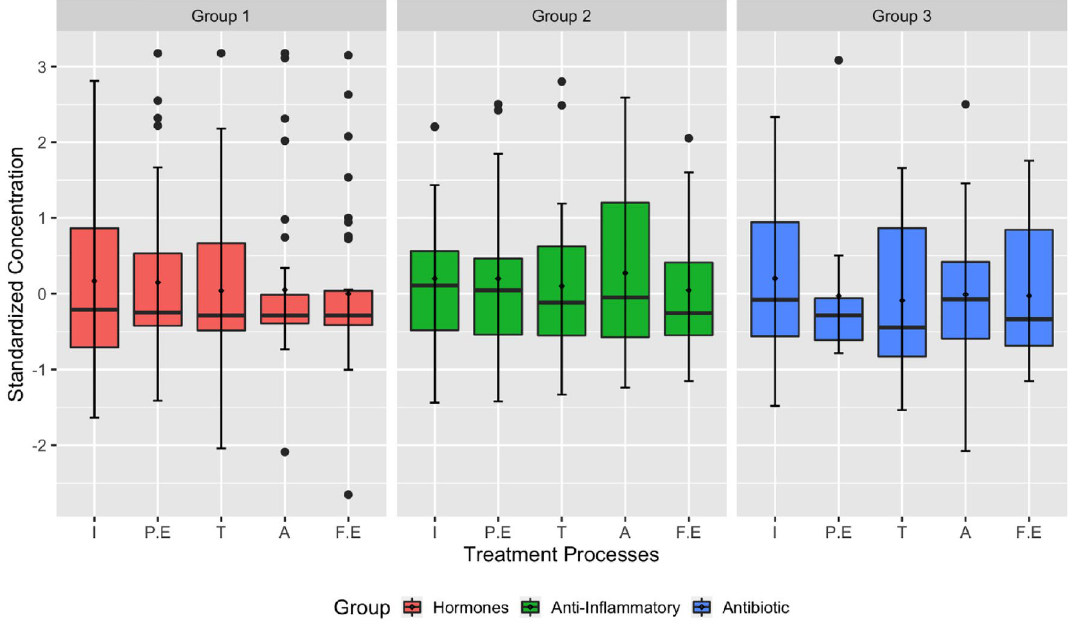
Fig. 2 The boxplots of the removal of compounds for groups across treatment processes, with standard error bars